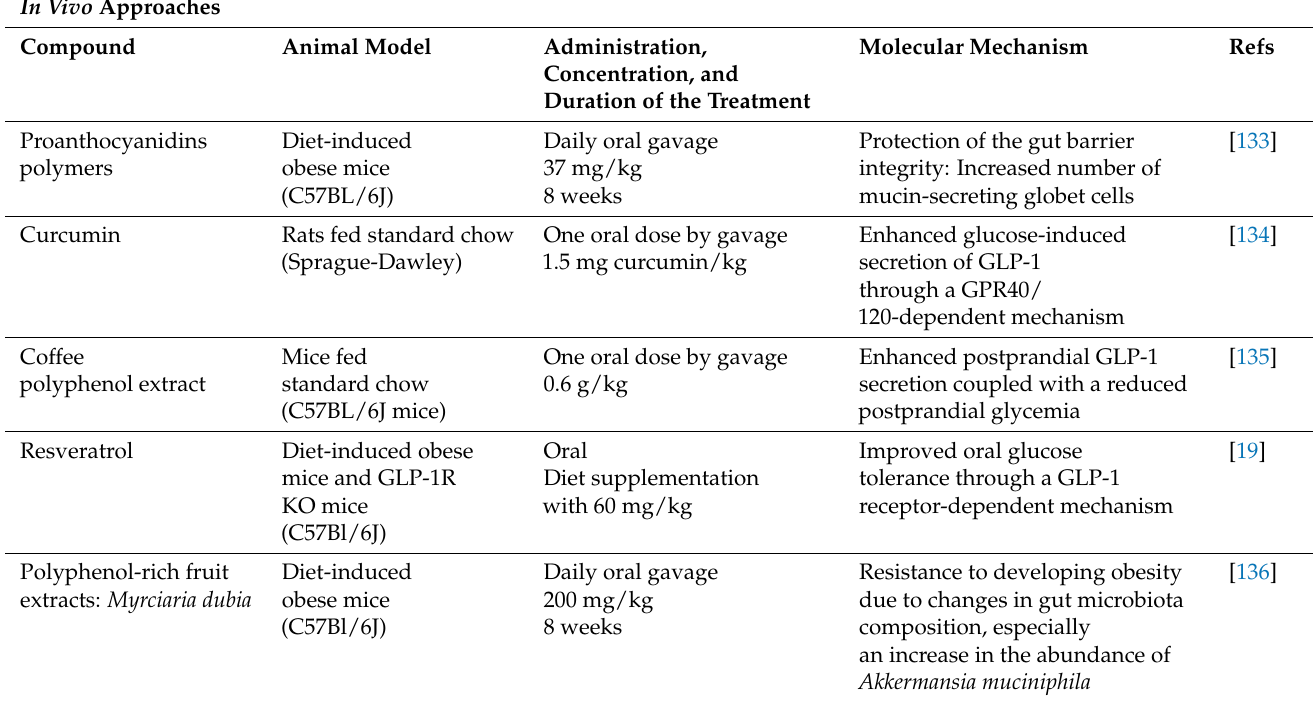
Table 4. Molecular mechanisms involved in the glucoregulatory effects of phenolic compounds. A focus on muscle, liver, and